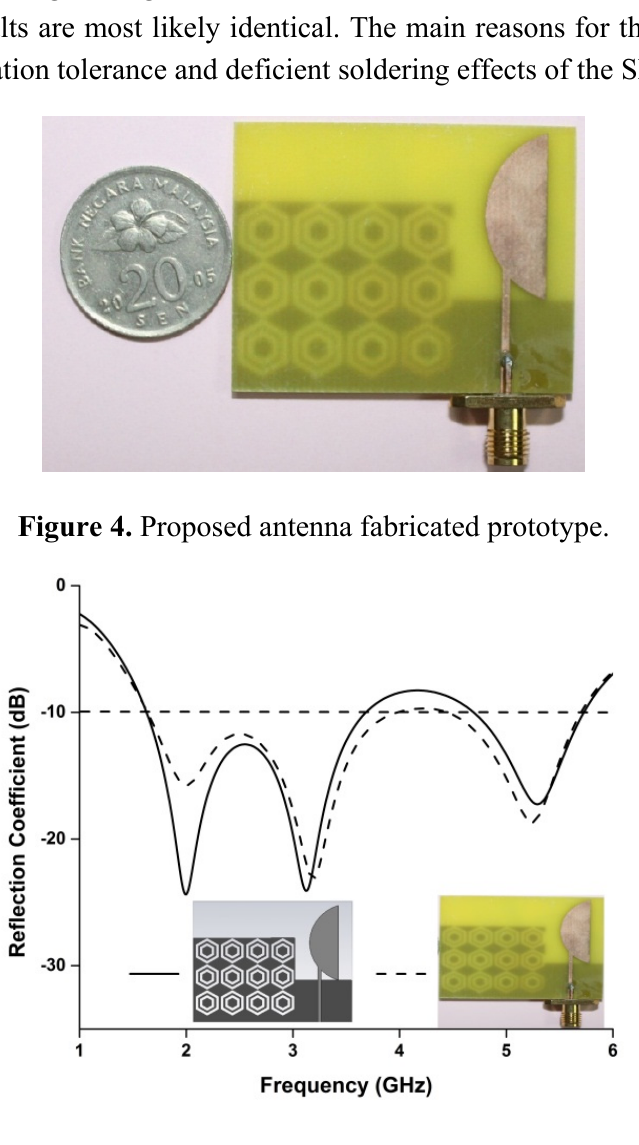
Figure 5. Simulated and measured reflection coefficients of the proposed